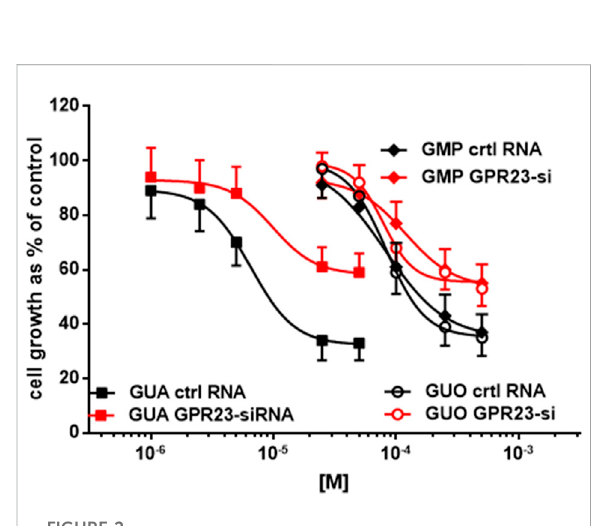
FIGURE 2 Effect of lipotransfection with GPR23-siRNA on sensitivity to GUA, GUO and GMP. Twenty-four hours after lipotransfection with GPR23-siRNA, U87 cells were treated with GUO or GMP (50 – 500 μ M) or GUA (1 – 50 μ M) for 72 h. Results are expressed as the percentage of cell growth evaluated in untreated cells (control) by the MTT assay. Each value is the mean ± SD of 10 different samples. Statistical signi fi cance of data obtained in GPR23-siRNA cells vs. control (ctrl) RNA transfected cells: p < 0.001for datarelatingtoGUAeffect and p < 0.01 forthoserelating to GUO and GMP effects (two-way ANOVA